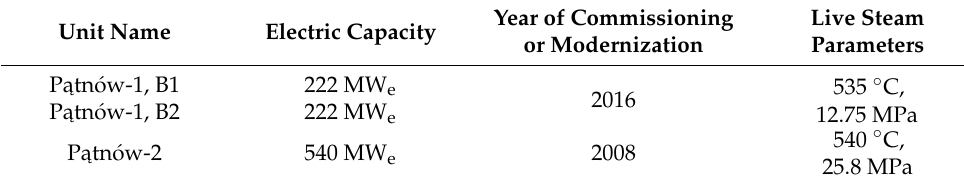
Table 4. Modern or modernized coal units at the P ˛atn ó w